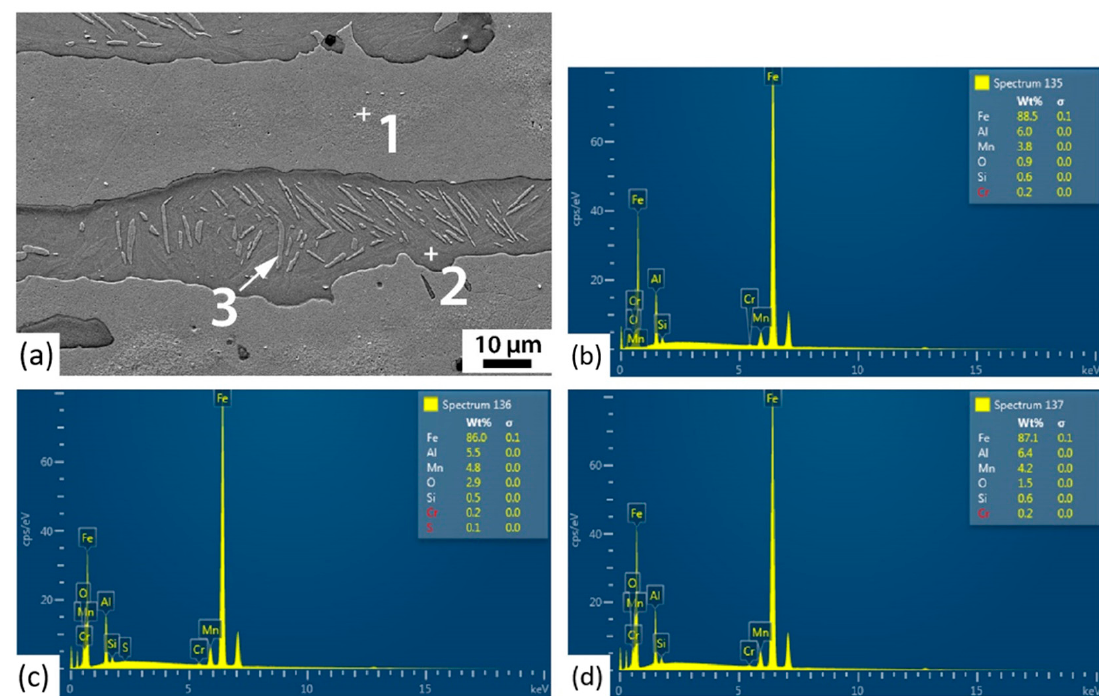
Figure 9. Corrosion pit, 6Al-4Mn-HT steel; ( a ) 5 min ( b ) 1 h, ( c ) 3 h immersion (3.5% NaCl).